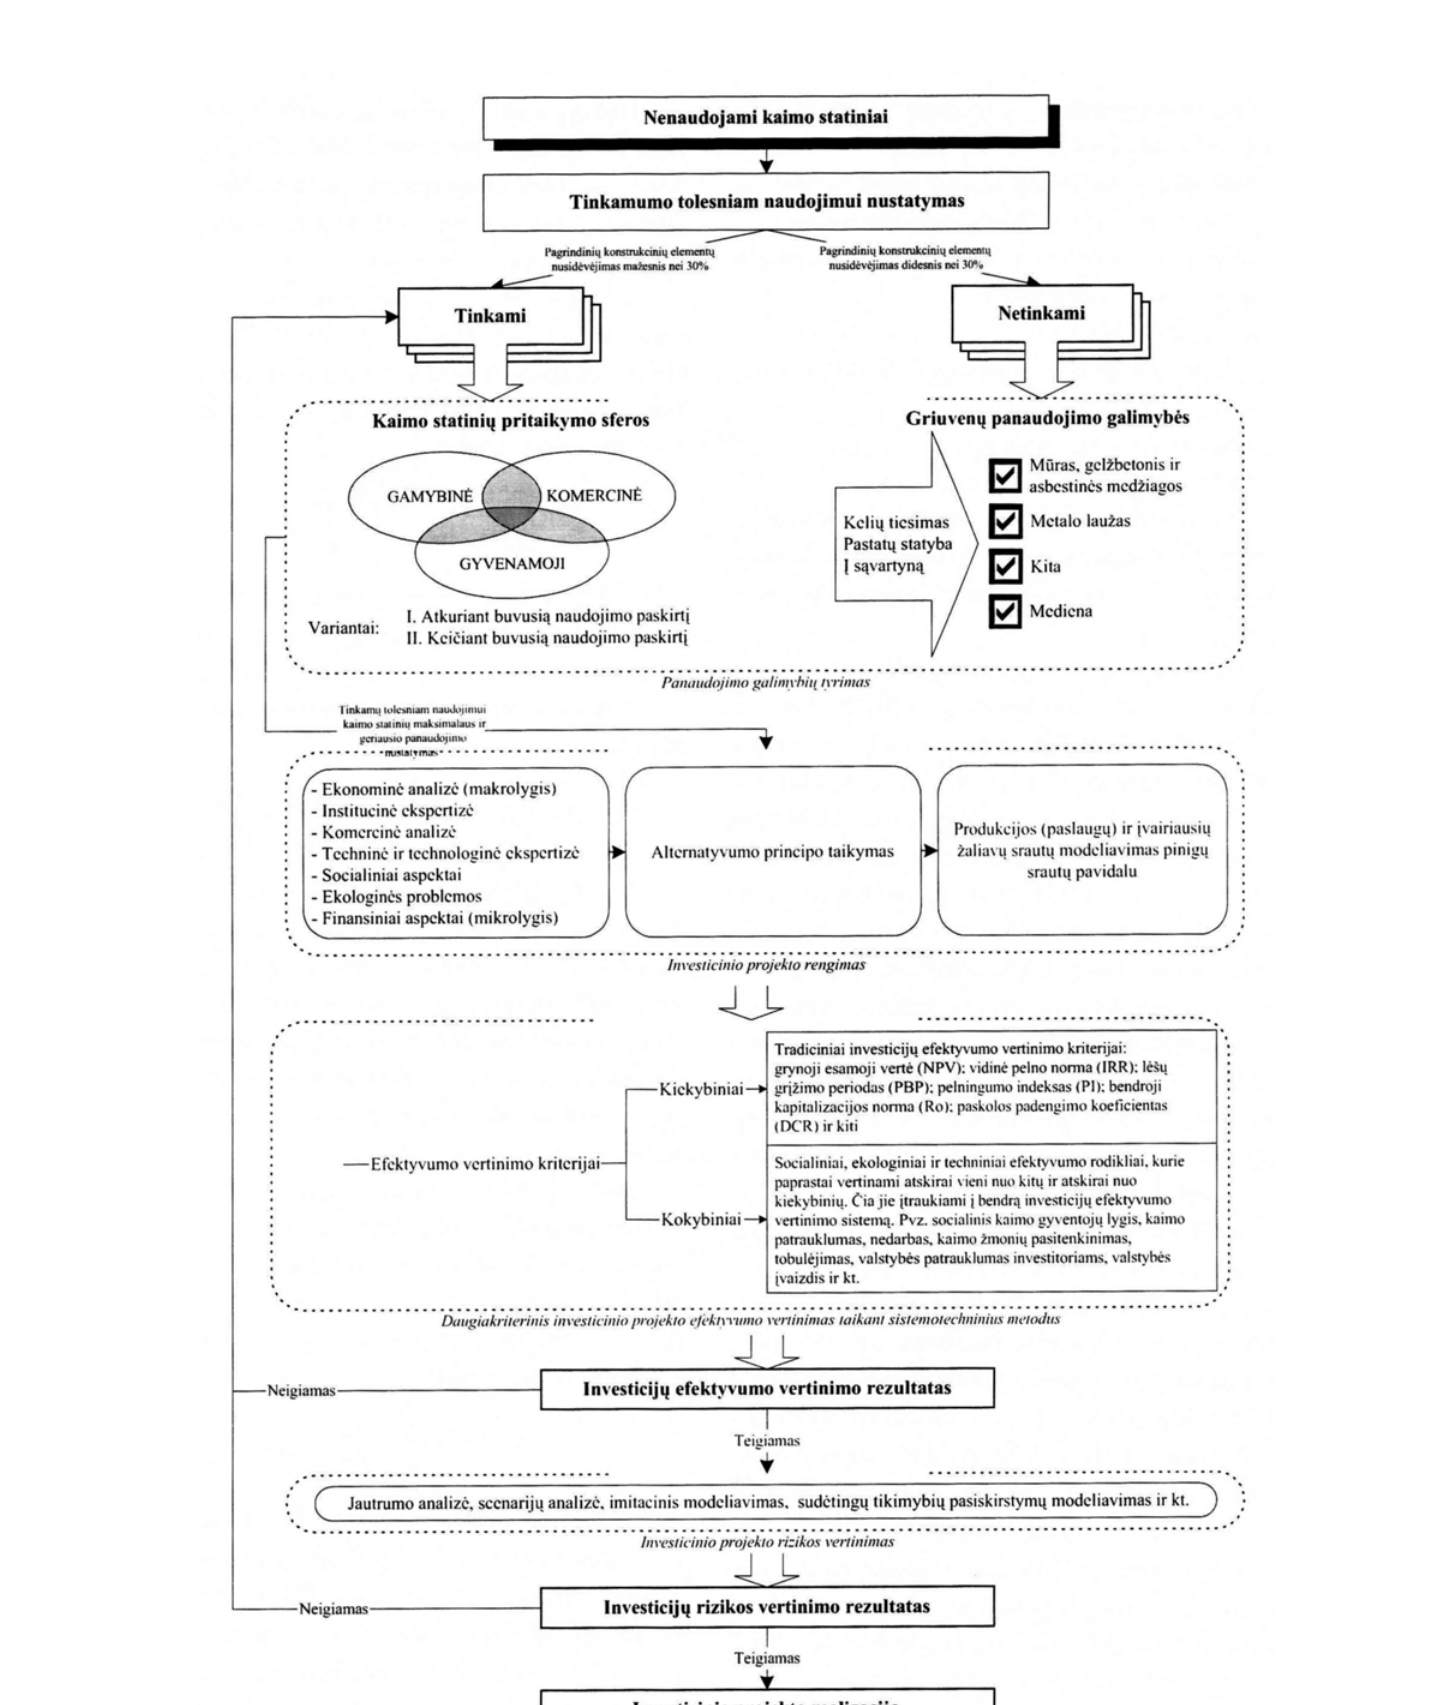
Fig 8. Logarithm of revitalization of unused rural